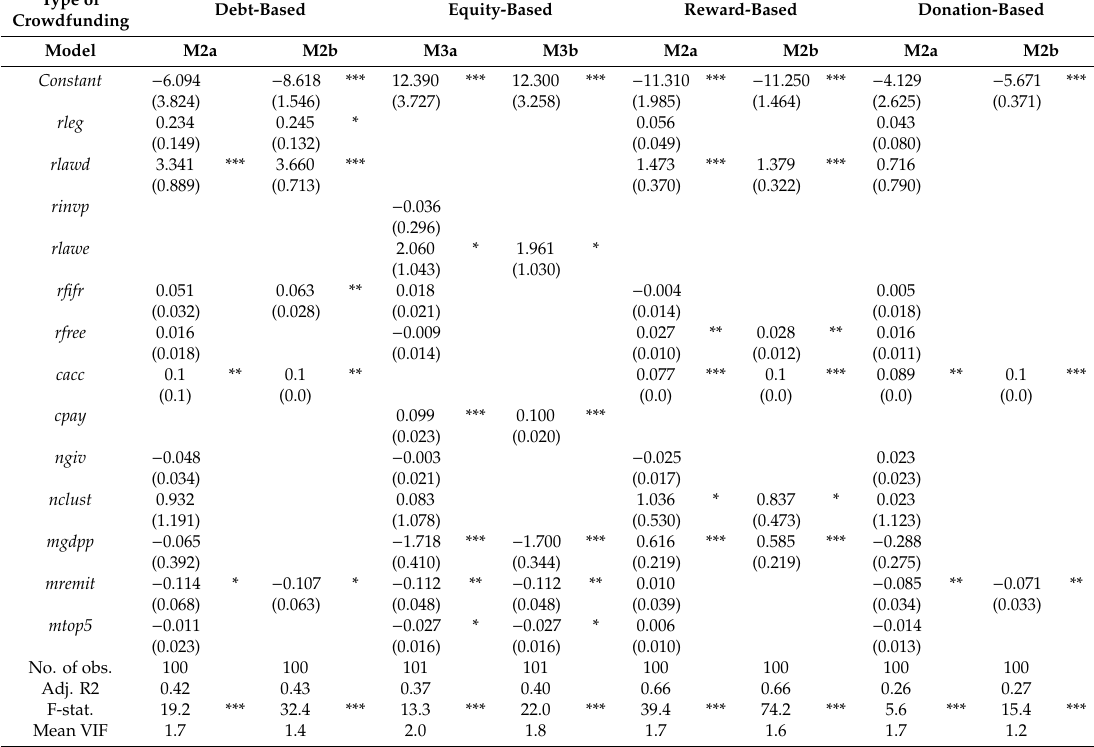
Table 6. Institutional determinants of total crowdfunding volumes during 2015–2016 per capita by types of